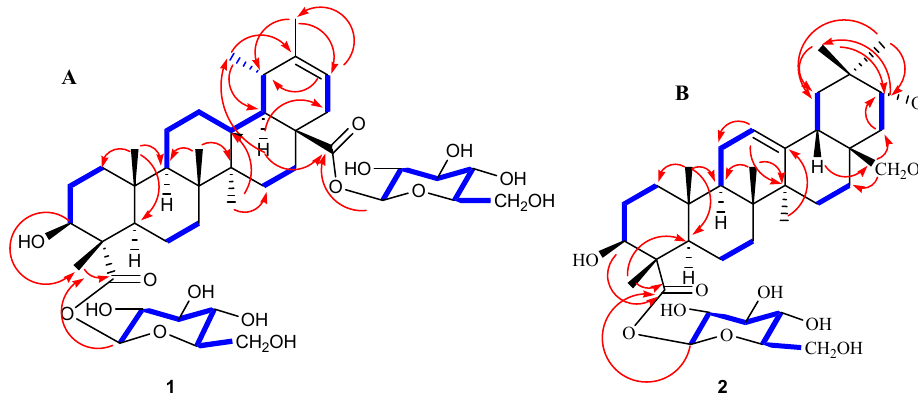
Figure 2. 1 H- 1 H COSY (blue bold bonds) and key HMBC (red arrows) correlations of 1 ( A ) and 2 ( B ).